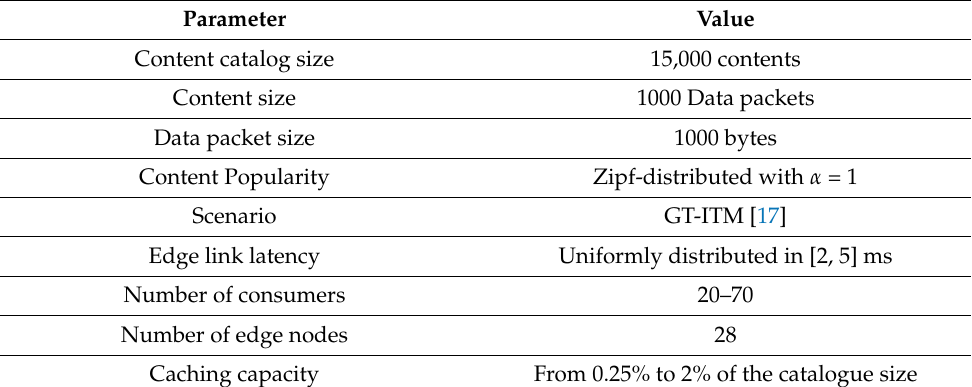
Table 3. Main simulation